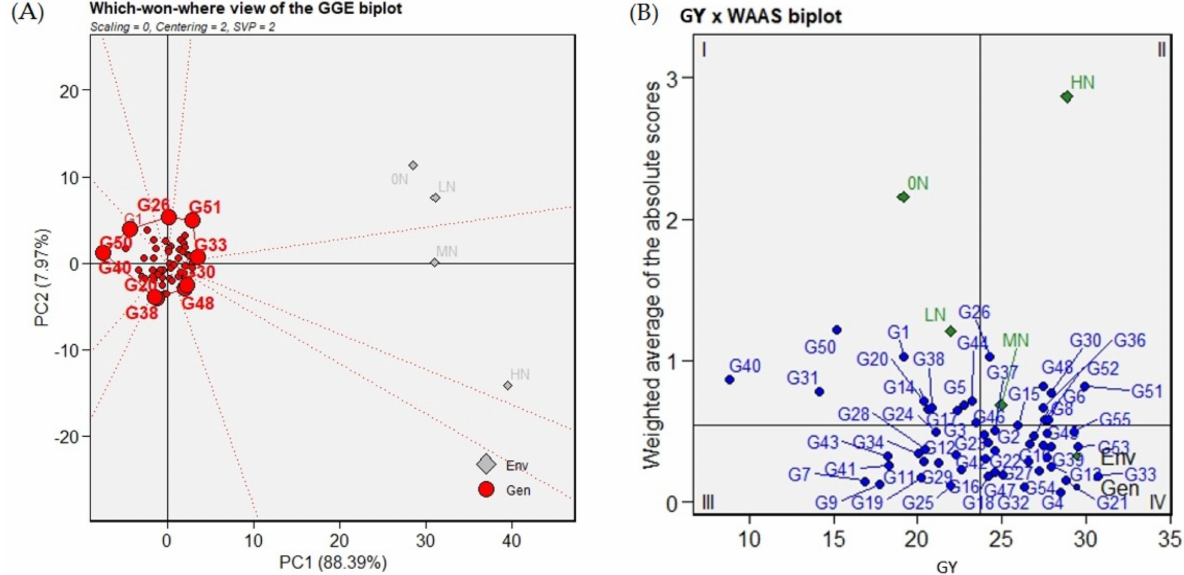
Figure 2. Which-won-where pattern based on the GGE biplot polygon to identify the best rice genotypes under the four different N environments ( A ). The GY × WAAS statistic biplot for selecting the high-yielding and stable rice genotypes ( B